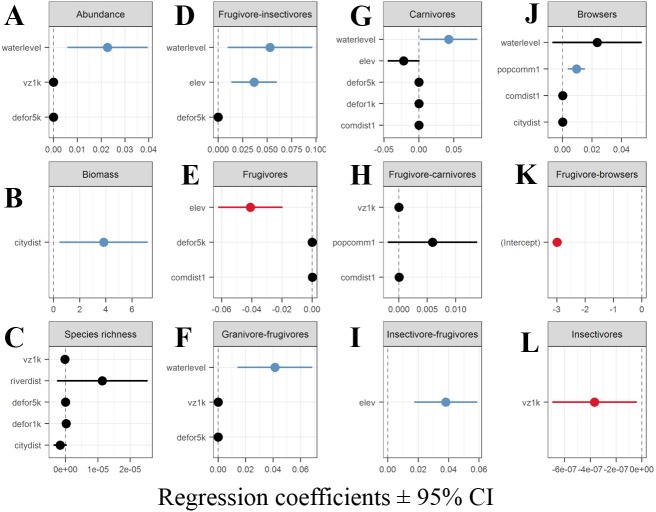
Coefficient estimates (± 95% confidence intervals) showing the magnitude and direction of effects of different explanatory variables retained in the best performing GLMs.(A) aggregate abundance, (B) aggregate biomass of all species, (C) species richness (D–L) numbers of detections of each trophic guild.